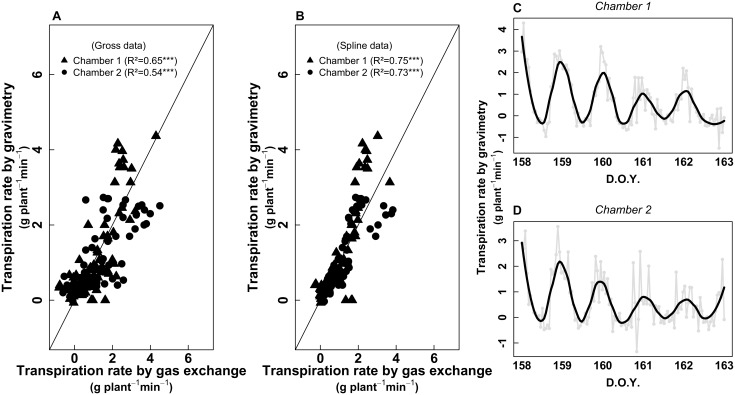
(A) Relationship between Transpiration rate (g H2O plant-1 min-1) estimated from gravimetry and gas exchange (whole-plant chamber). The continuous line represents the 1:1 relationship. (B) Same relationship but with data treated with a spline. The continuous line represents the 1:1 relationship. (C,D) gross data of gravimetry [gray circles and lines, same as presented in (A)] for chambers 1 and 2, respectively. The black lines represent the data treated with a spline in order to remove non-biological noise, as presented in (B). The data in (A,B) come from two sampling sessions (first session: from D.O.Y. 143–150; second session: from D.O.Y. 158–163; see Figure 1).